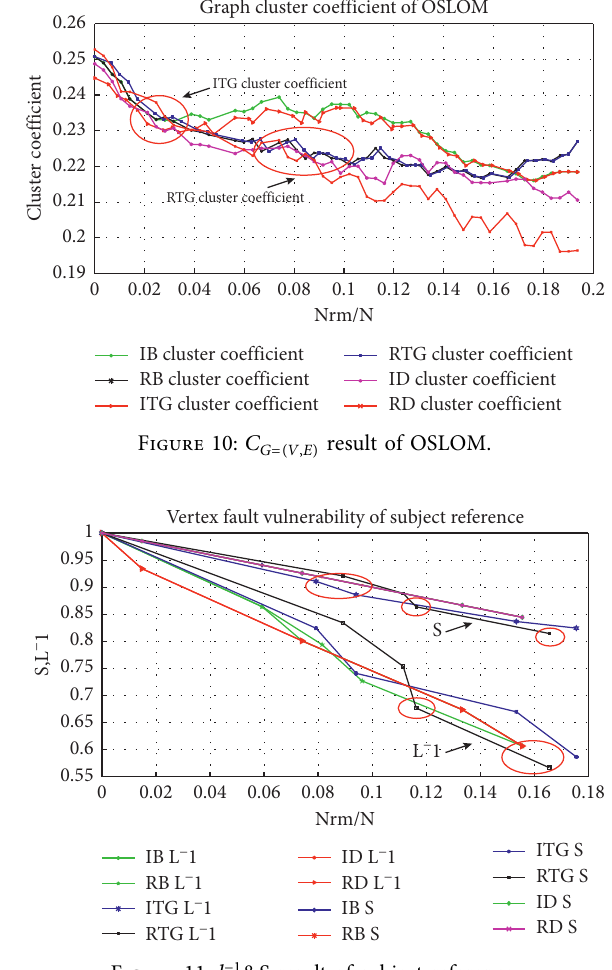
Figure 11: l − 1 & S result of subject